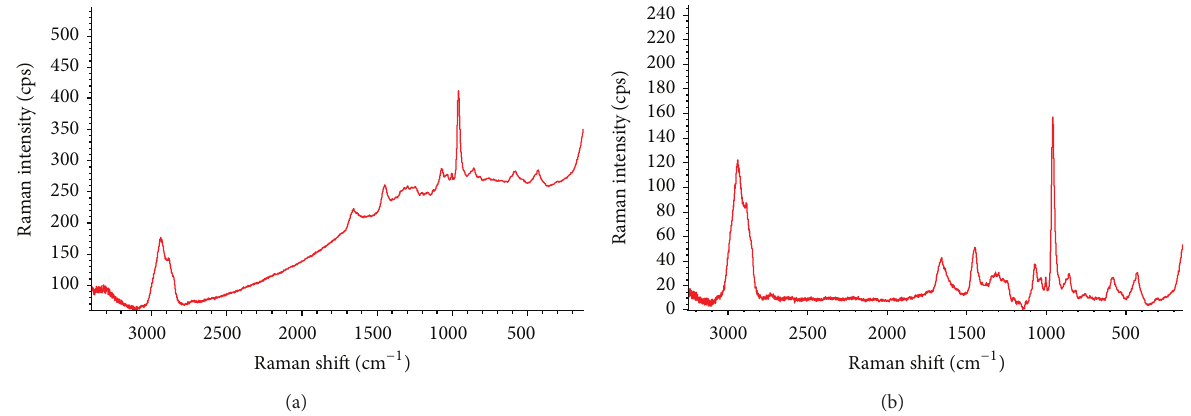
Figure 4: (a) Raman spectrum of pork bone showing fluorescence. (b) Corrected Baseline of the same